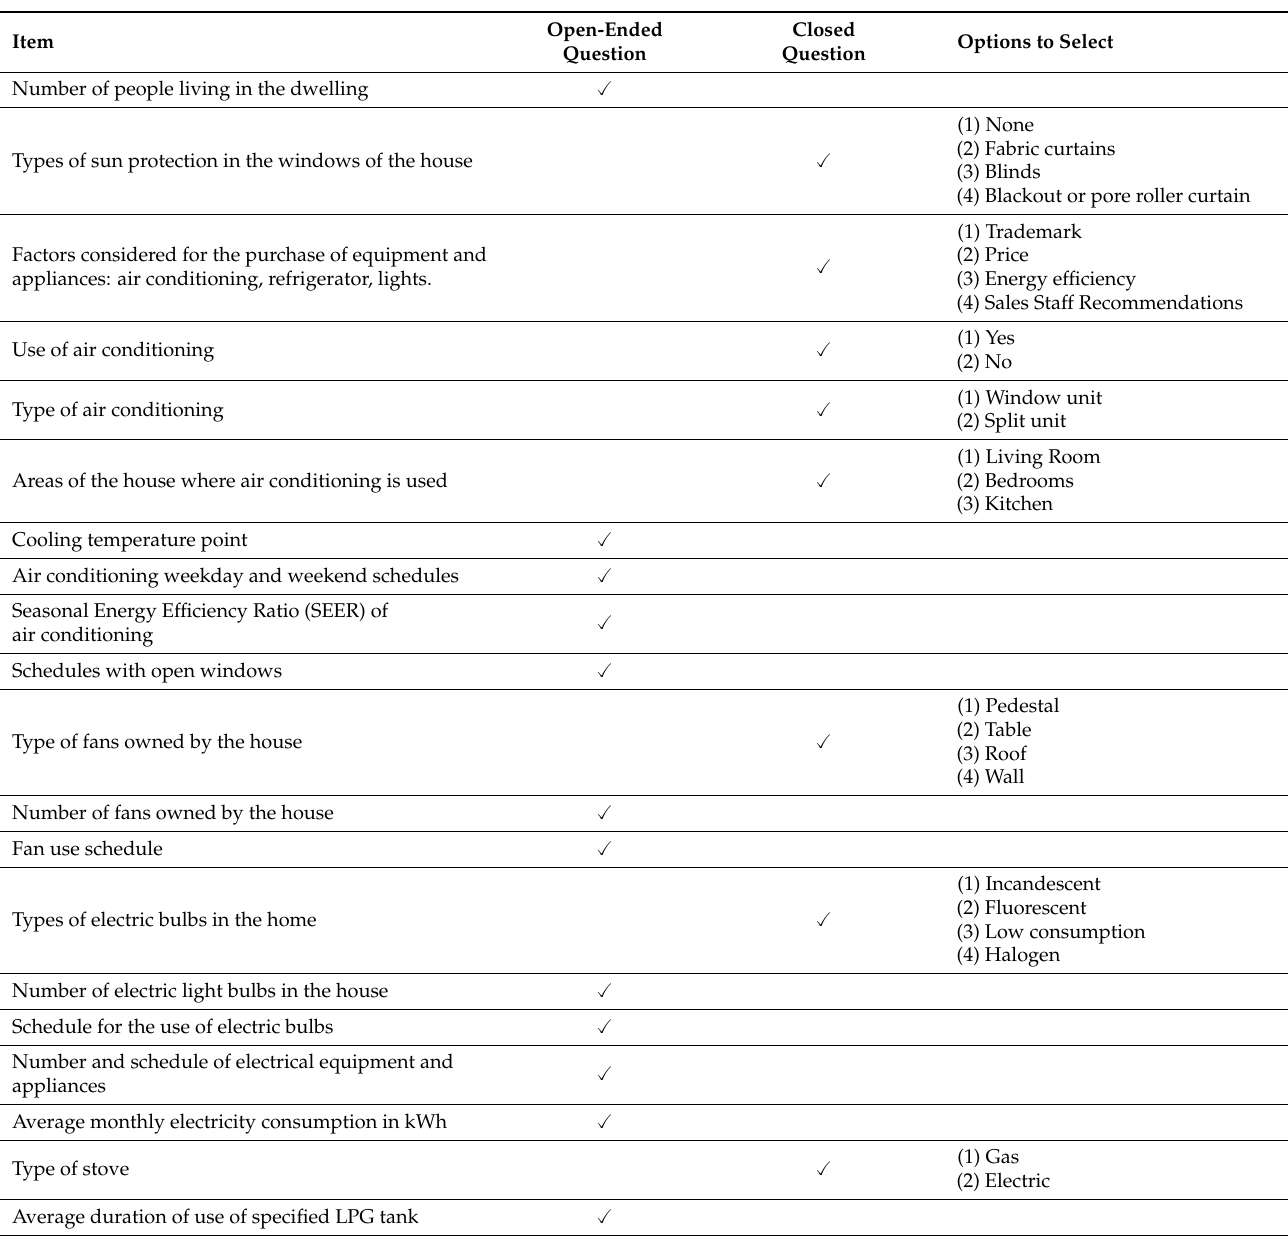
Table A1. Survey questions applied to housing